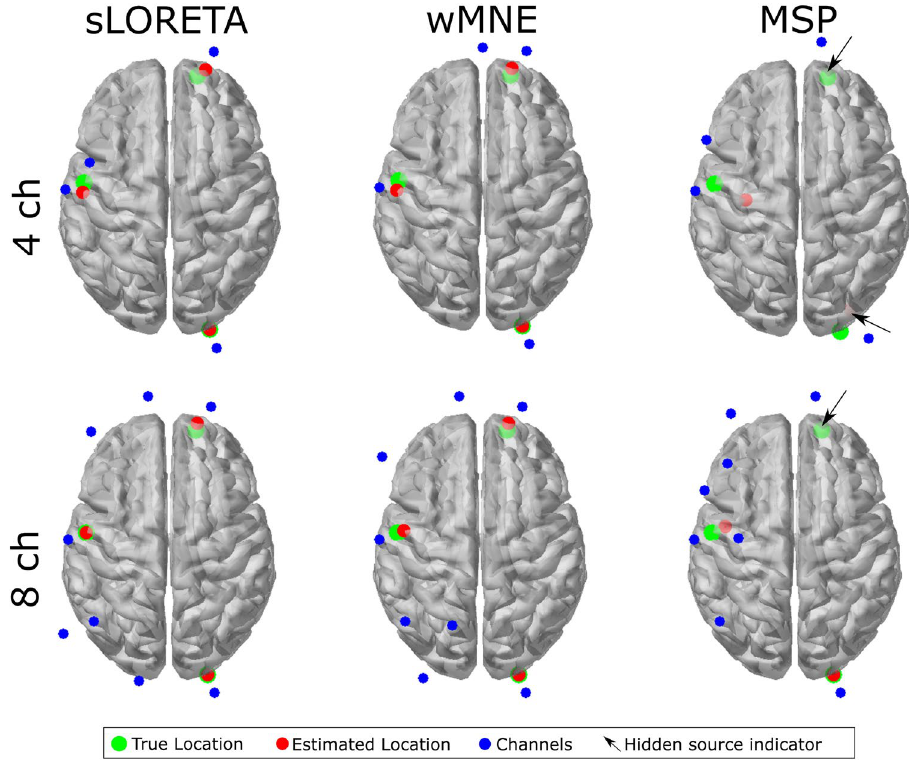
Figure 8. Optimized combinations and source localization for one trial during the multiple-source test 231e. The mean localization errors with four channels were 5.3, 4.7, and 14.5 mm, and with eight channels were 2.4, 4.2, and 4.5 mm, for sLORETA, wMNE, and MSP, respectively. The hidden source indicator is intended to point to where there is a source that can not be seen from the top